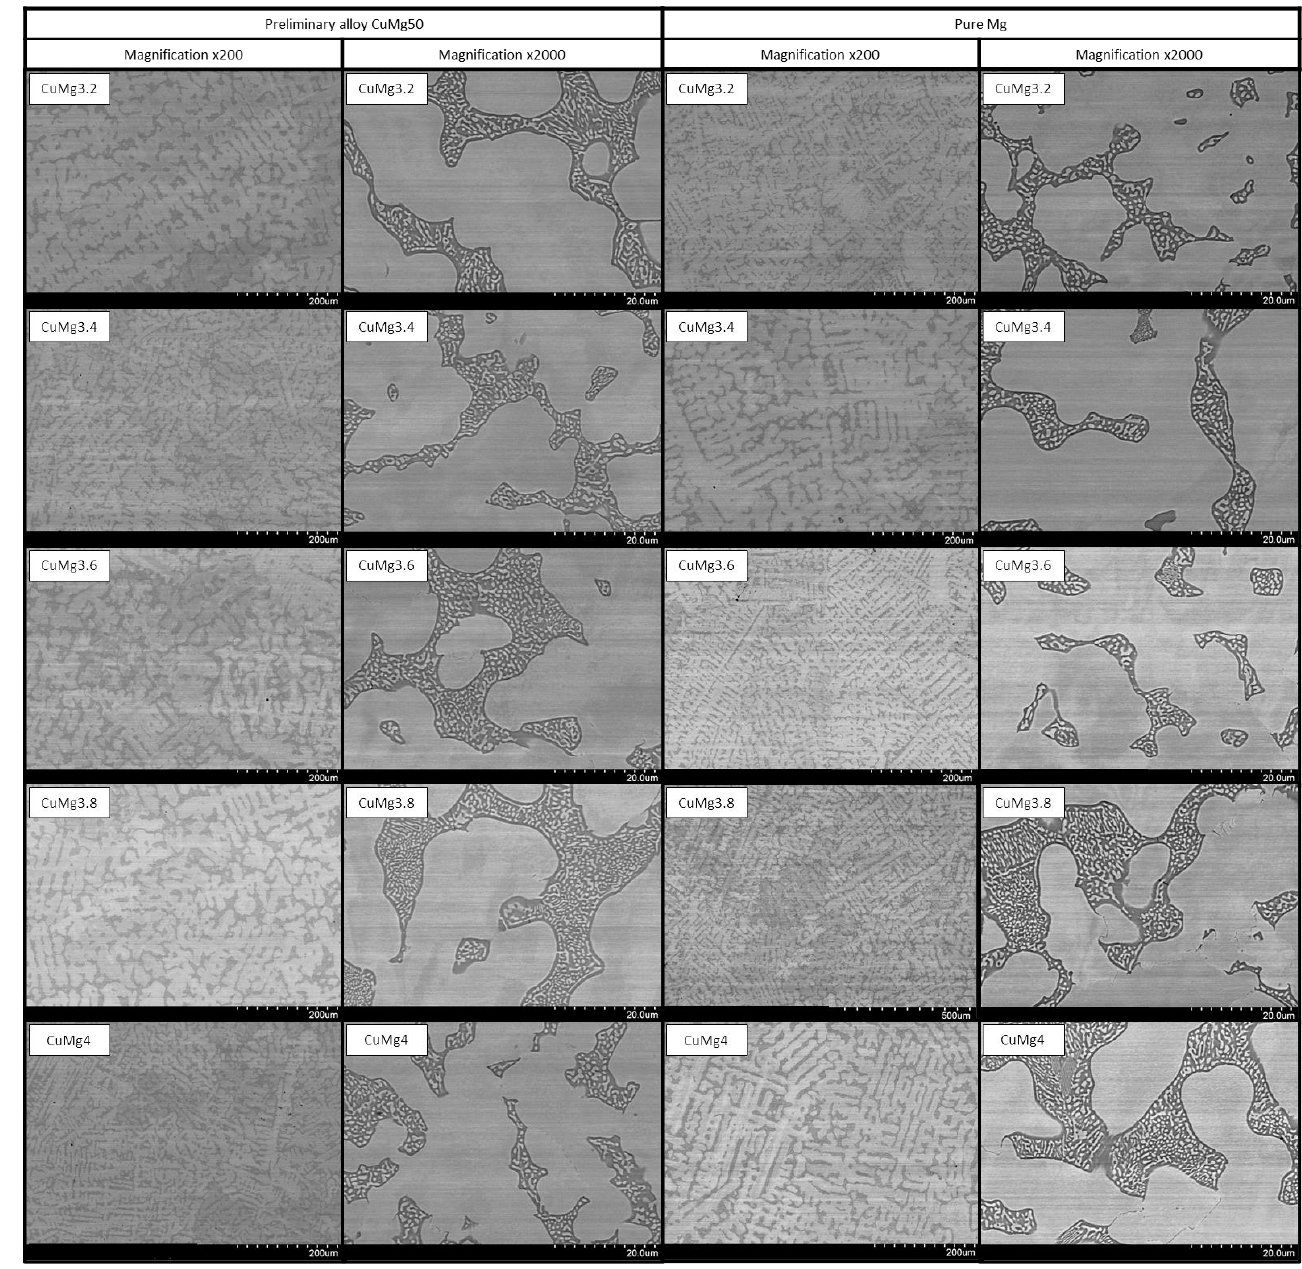
Figure 5. Backscatter electron SEM analysis of CuMg alloys in the as-cast state obtained with preliminary alloy CuMg50 (on the left) and pure Mg (on the right) with two magnifications (200× on the left and 2000× on the right); the analyzed chemical composition of the alloy is marked on each of the images.